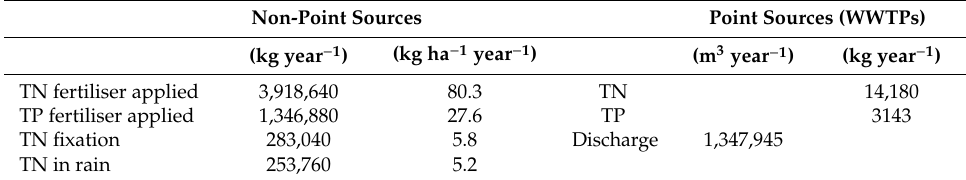
Table 4. Inputs of TN and TP in the Rio Mannu basin from point and non-point sources as average annual values from 1997 to